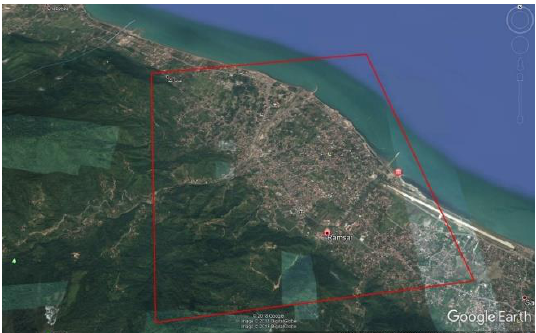
Figure 1. Study area (Ramsar) in Google Earth Pro.